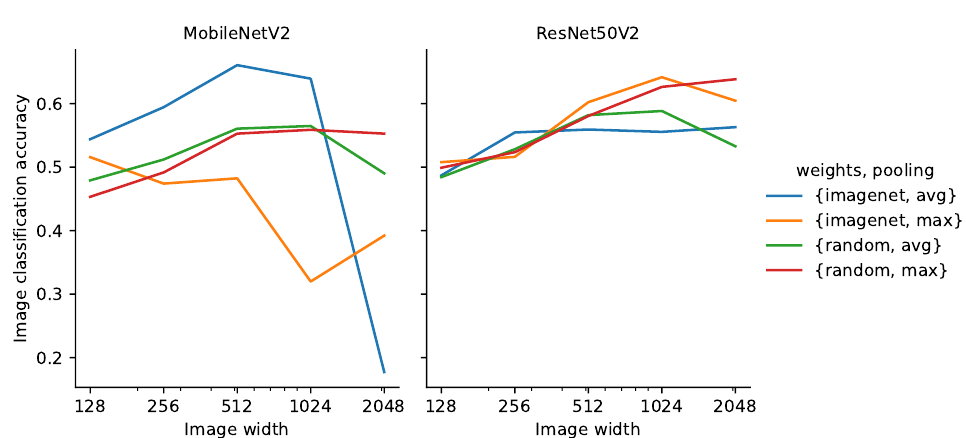
Figure 7. Image classification accuracy across all species on the validation set using MobileNetV2 and ResNet50V2 as a function of input image